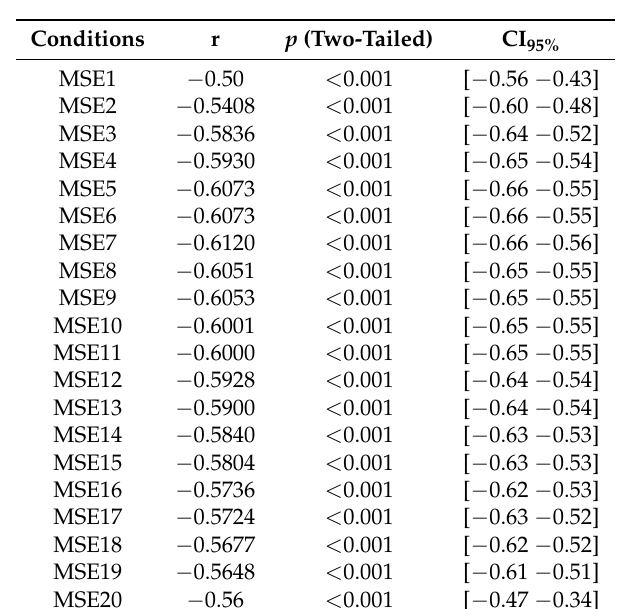
Figure A9. Positive mental state. Spearman correlation between participants’ DEs (i.e., 62 DEs associated with 62 EEG channels of a participant, per affect) and their corresponding MSE1s (i.e., 62 MSE1s associated with 62 EEG channels of a participant, per affect) through MSE20s (i.e., 62 MSE20s associated with 62 EEG channels of a participant, per affect) values. The subplots in the right column correspond to bootstrap correlation test (10,000 simulation runs) at 95.0% confidence interval. The values associated with these subplots are summarized in Table A9. Table A7. Bootstrap (10,000 simulation runs) 95.0% confidence intervals (CI) associated with the Spearman correlation between MSE1s (i.e., 62 MSE1s associated with 62 EEG channels of a participant, per affect) through MSE20s (i.e., 62 MSE20s associated with 62 EEG channels of a participant, per affect) and DEs (i.e., 62 DEs associated with 62 EEG channels of a participant, per affect) in the negative mental